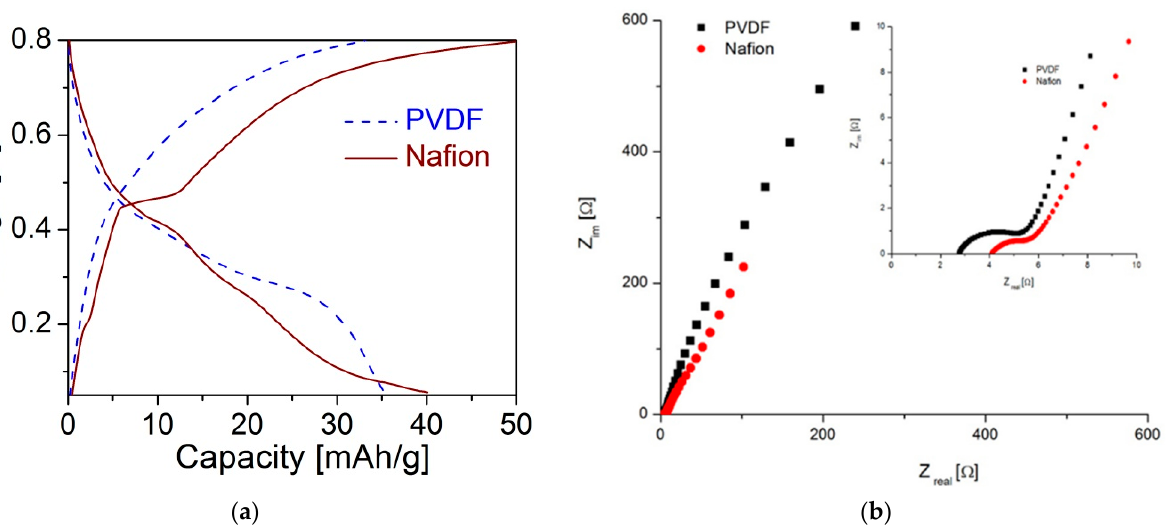
Figure 7. ( a ) Galvanostatic curves obtained for the composite electrodes comprising VOPO 4 ∙ 2H 2 O, carbon black, and a binder (PVDF or Nafion) in Al(NO 3 ) 3 saturated aqueous solution; applied current: 20 mA/g. ( b ) The corresponding Nyquist plots for two cells with these electrodes. The inset is enlarged high ‐ frequency region.